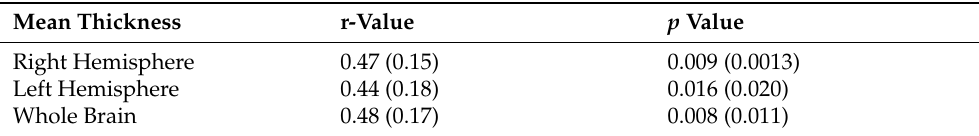
Table 1. Mean values and standard deviations (in brackets) of Pearson correlation (r) and correspond- ing p values evaluated between the real and predicted values across 50 repetitions.